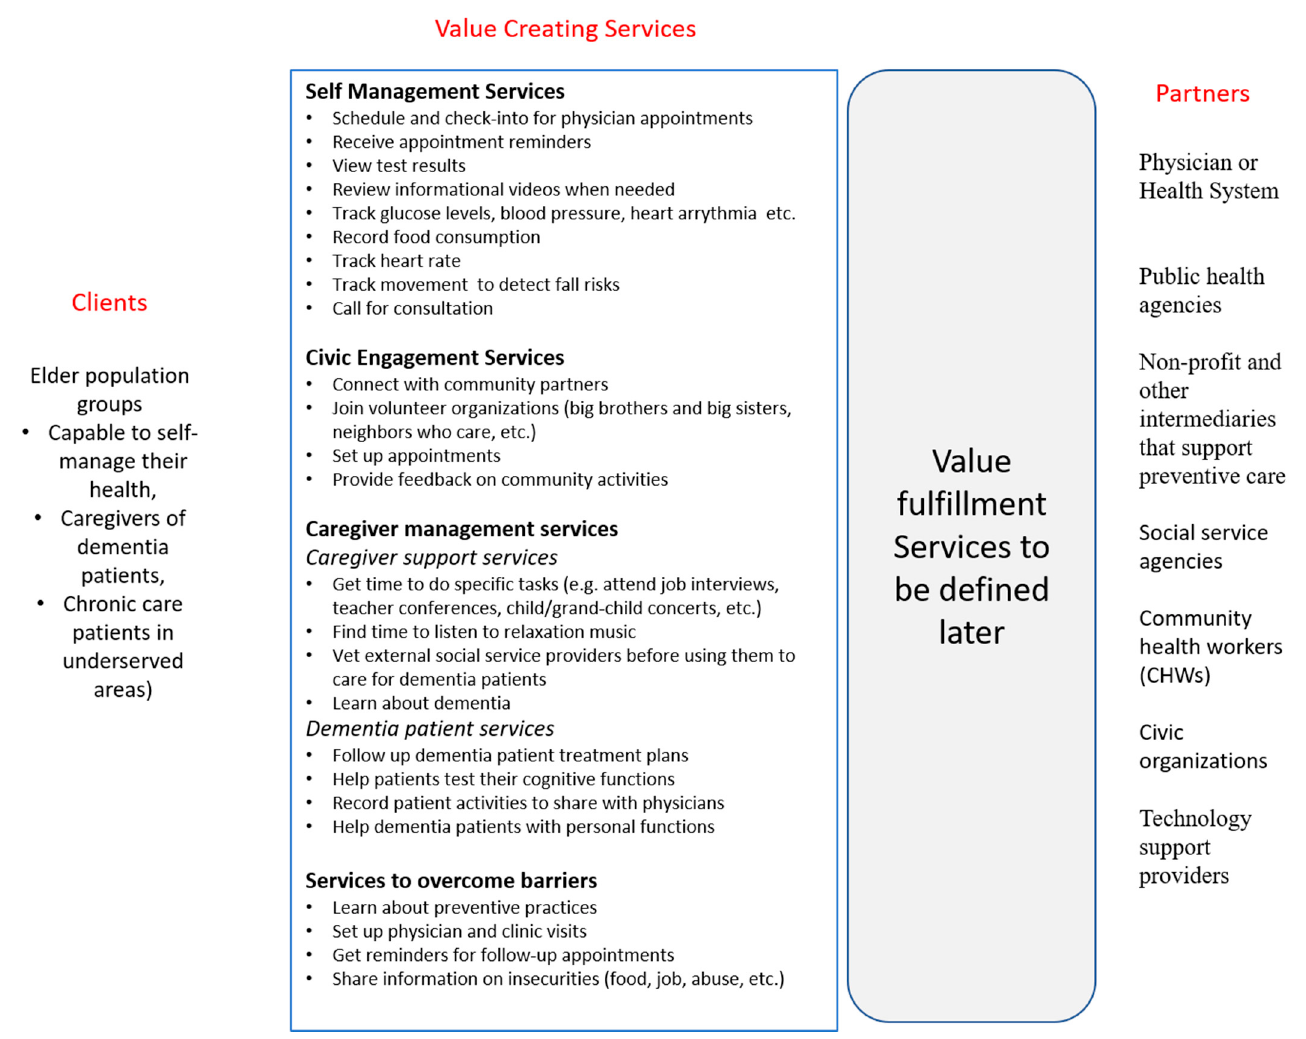
Figure 1. A template of services to support select population groups.